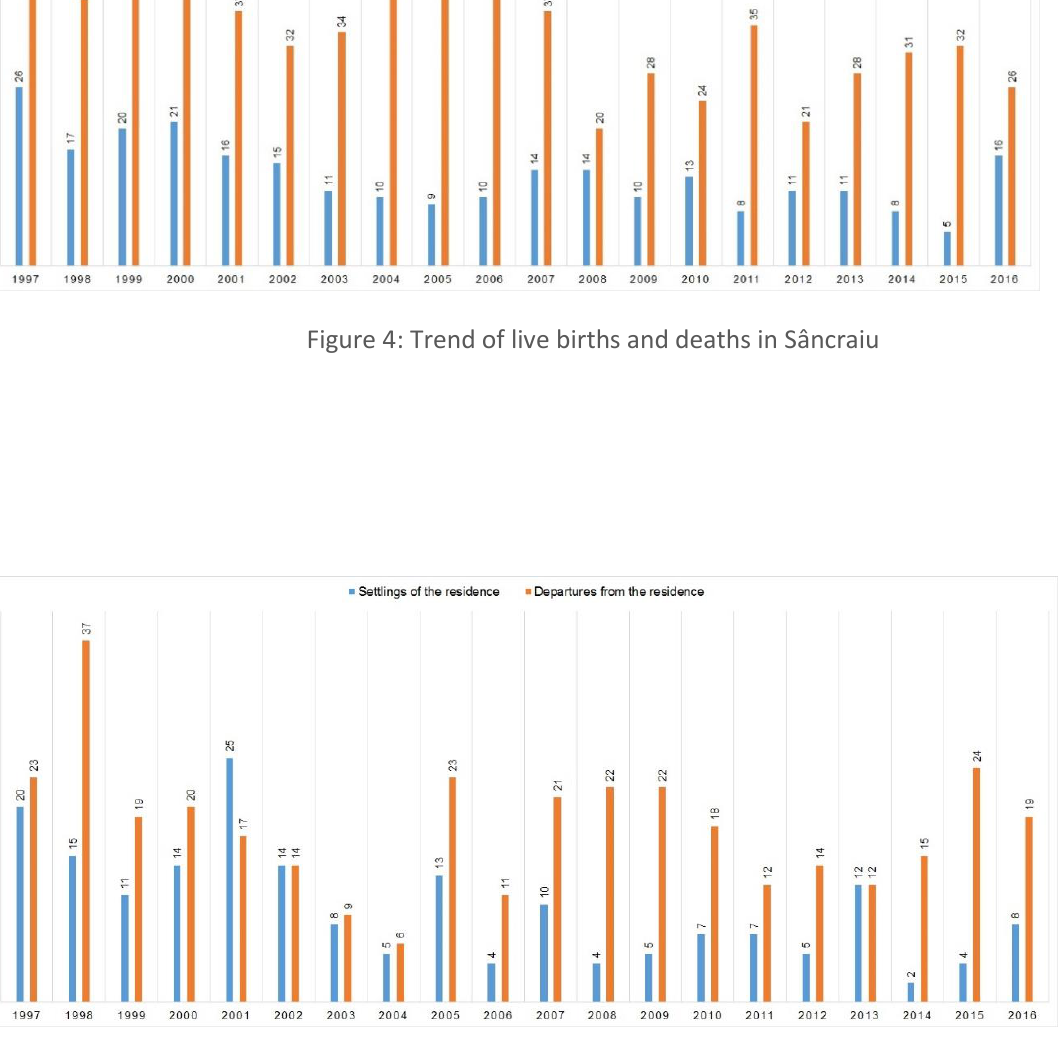
Figure 5: Changes of permanent residence – Izvoru